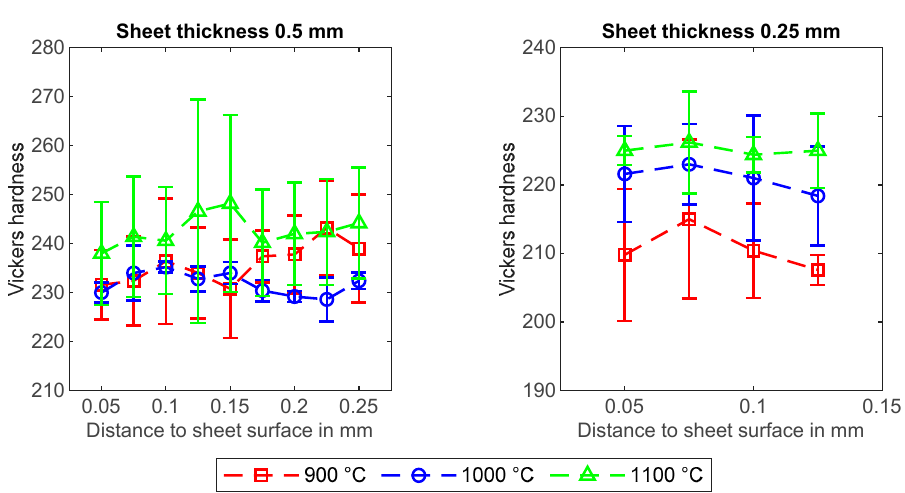
Figure 3. Results of hardness measurements on the steel sheets’ cross sections. A Vickers spike and a test force of 0.25 N were used for the measurements. Table 2. Overview of produced electrical steel sheets. Values in brackets represent the standard Table 3. Applied cutting clearances and the cutting clearance/sheet thickness ratios. deviation. Sheet